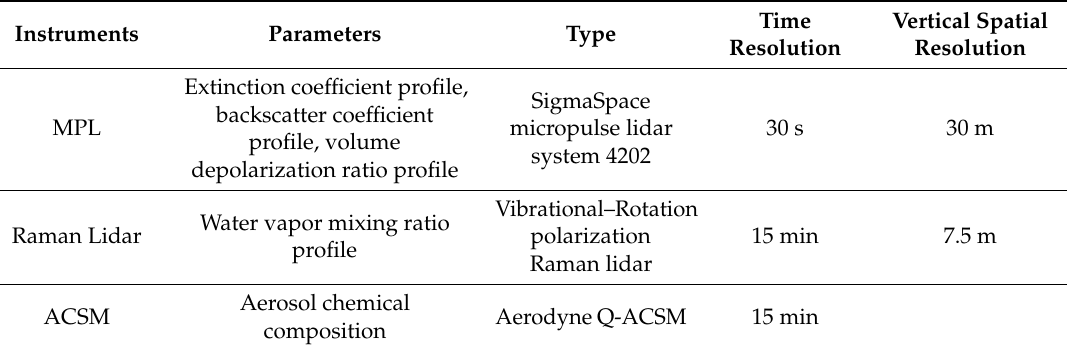
Table 1. List of instruments and